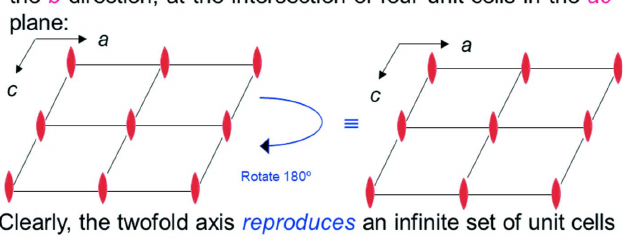
Figure 6 Slide 3, Chapter